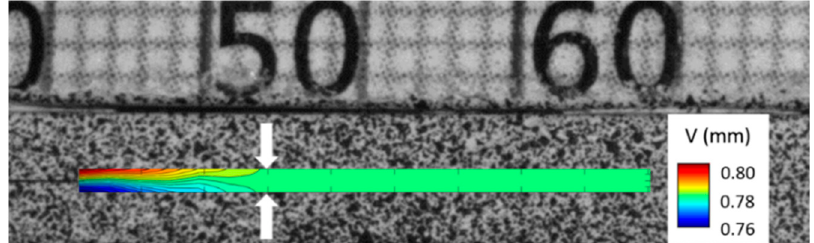
Figure 1. Vertical displacement field around the delamination by DIC analysis in Mode I